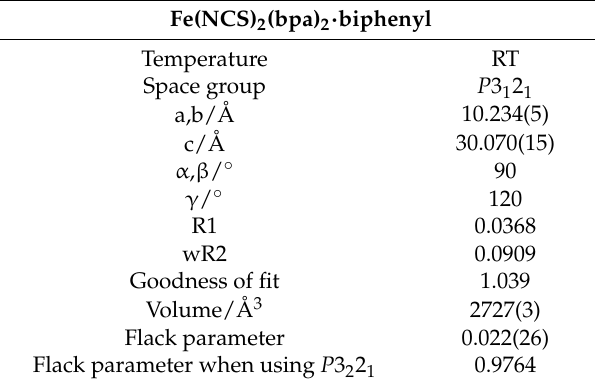
Table 2. Crystal data of [[Fe(NCS) 2 (bpa) 2 ] · biphenyl] n .